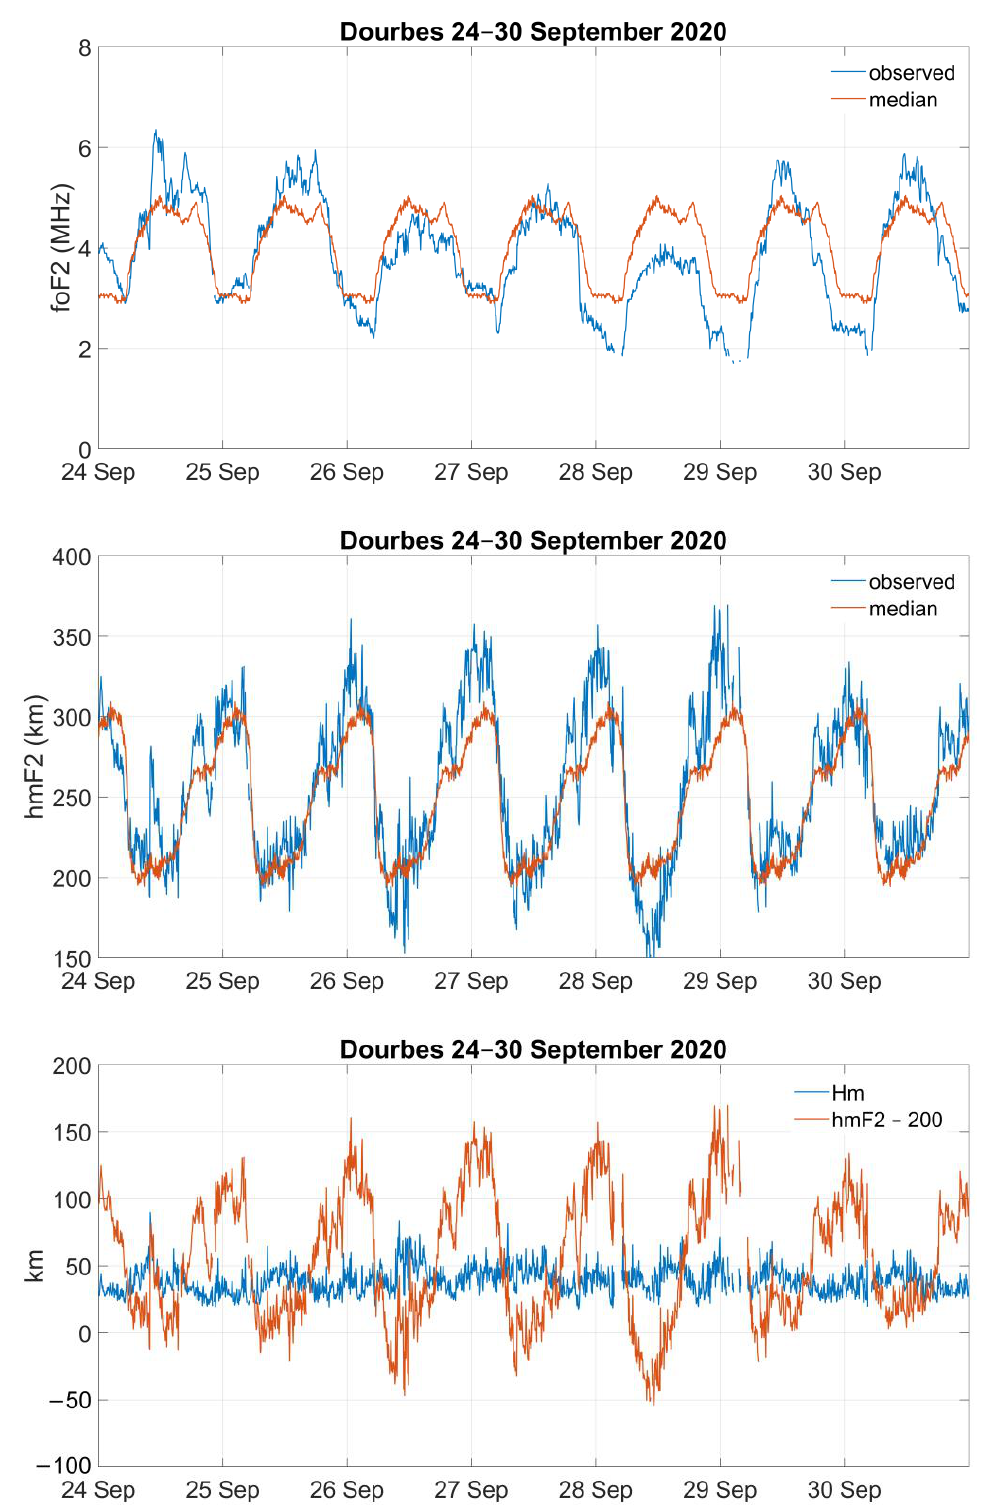
Figure 7. The ionospheric characteristics extracted from the Dourbes Digisonde; manually scaled ionograms from 24 to 30 September 2020. Top to bottom panels show: the Dst records for this time interval ( top panel ); the observed (blue line) and monthly medians (orange line) of the critical frequency of the F2 layer, foF2 ( second panel ); the true height of the maximum electron density, hmF2 ( third panel ); and the scale height (Hm) together with the variation of (hmF2-200) ( bottom panel ).